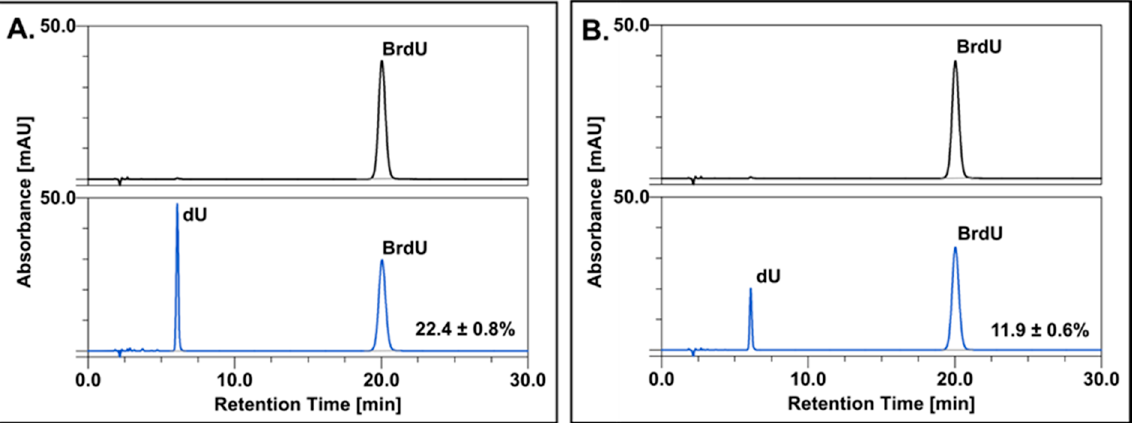
Figure 1. HPLC traces for a solution of BrdU before (black chromatogram) and after irradiation with a dose of 140 Gy (blue chromatogram) under anaerobic ( A ) and aerobic ( B ) conditions. a dose of 140 Gy (blue chromatogram) under anaerobic ( A ) and aerobic ( B )